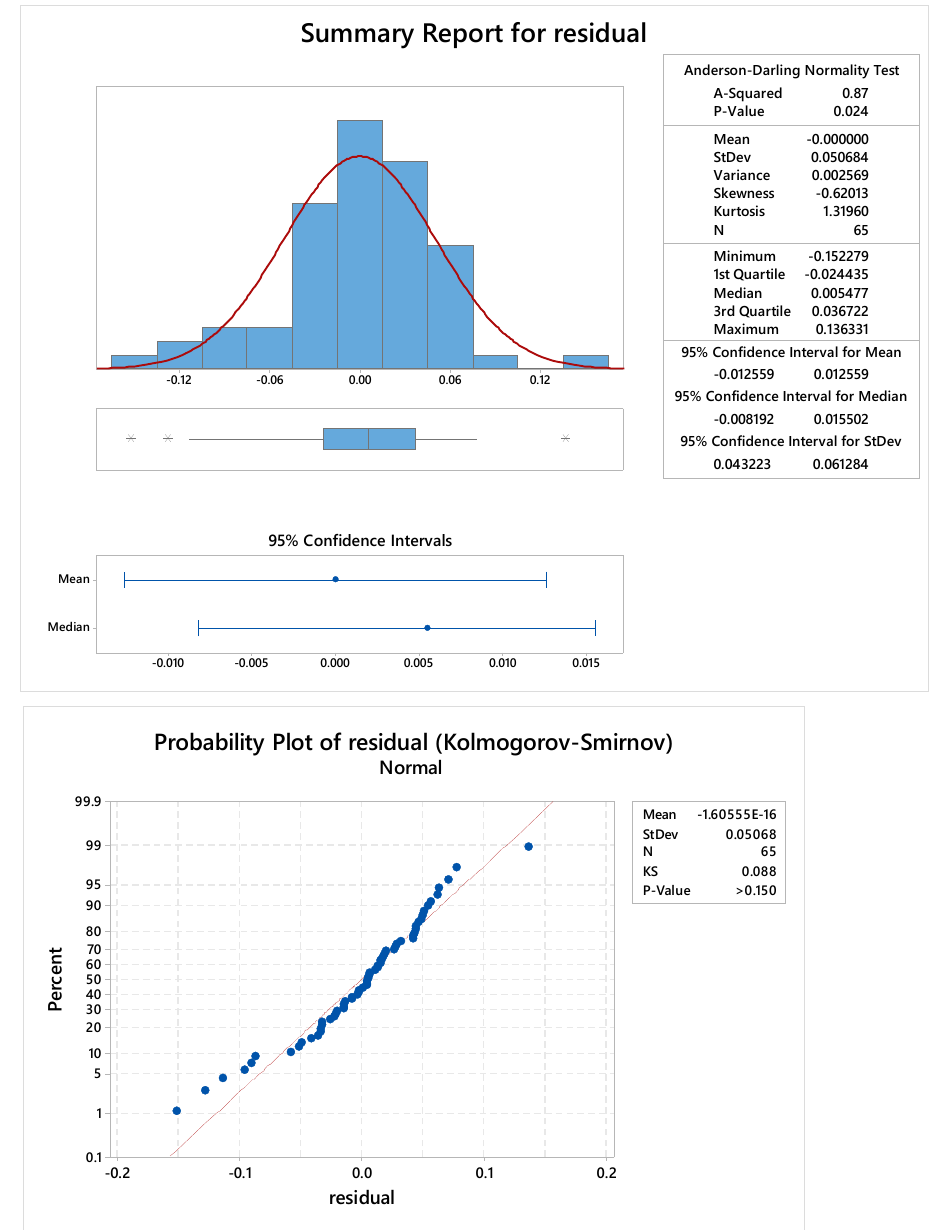
Figure A16. Residual distribution analysis for sample Linearity determination for quantification of S. flexneri 6 OAg by HPAEC-PAD (data from six analysis sessions together); * potential outliers.